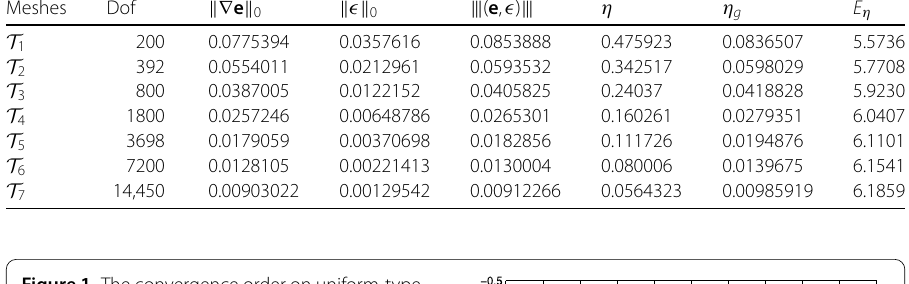
Figure 1 The convergence order on uniform-type mesh: P 1 – P